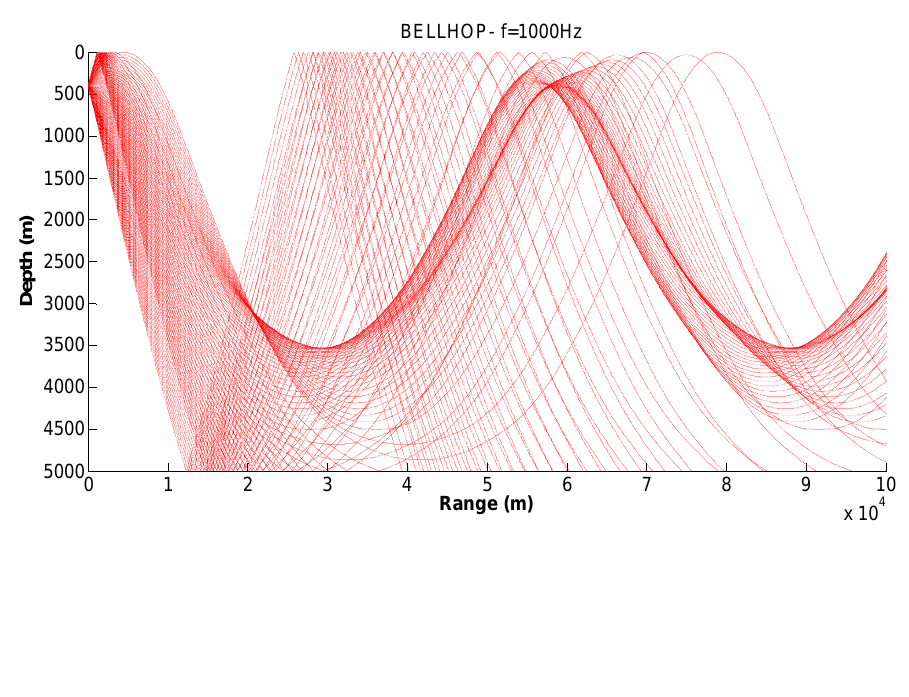
Figure 11. Corresponding ray trace for a source depth of 400